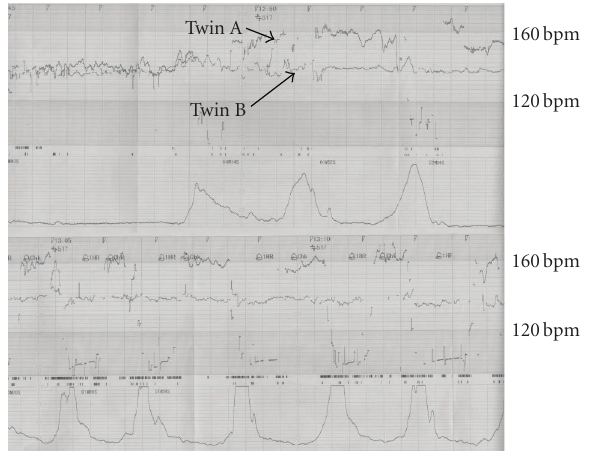
Figure 2: Fetal heart rate tracings during the active phase of labor showing the increased baseline of heart rate with variable decelerations in twin